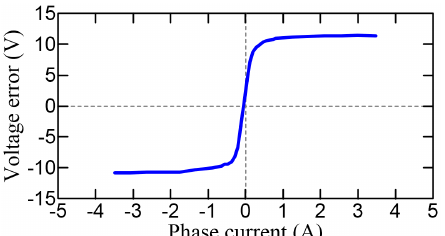
Figure 3. The voltage error caused by the dead-time at different phase current.